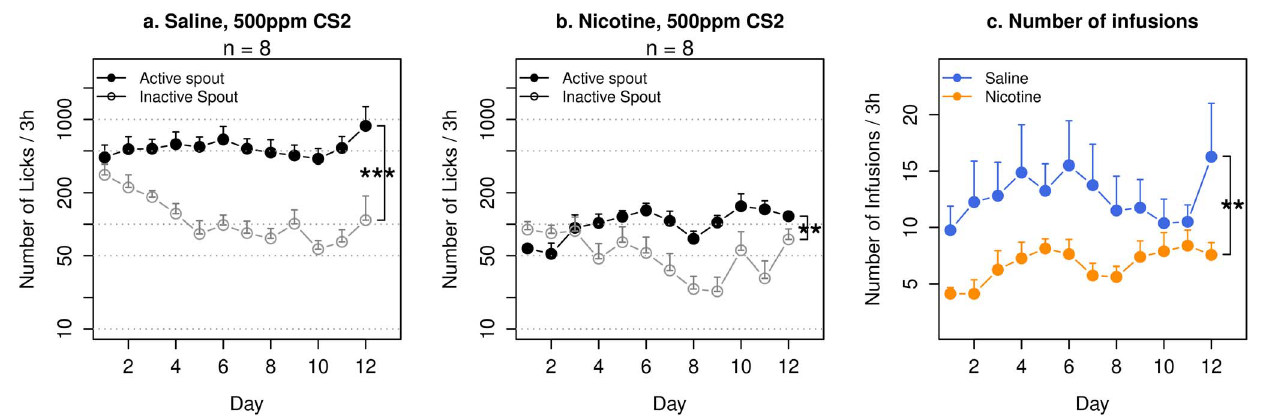
Fig. 1. Nicotine self-administration with CS 2 in adolescent rats. Adolescent female Sprague-Dawley rats implanted with jugular catheters were placed in operant chambers equipped with two lickometers. Licking on the active spout that met a fixed-ratio 10 reinforcement schedule triggered contingent delivery of oral CS 2 (500 ppm, dissolved in water) and i.v. saline (a) or i.v. nicotine (b). No olfactogustatory cue was used. Both groups showed preference for the active spout. The average number of infusions (c) was 12.9 ¡ 1.9 for rats that self-administered saline, and 6.7 ¡ 0.4 for rats that self-administered